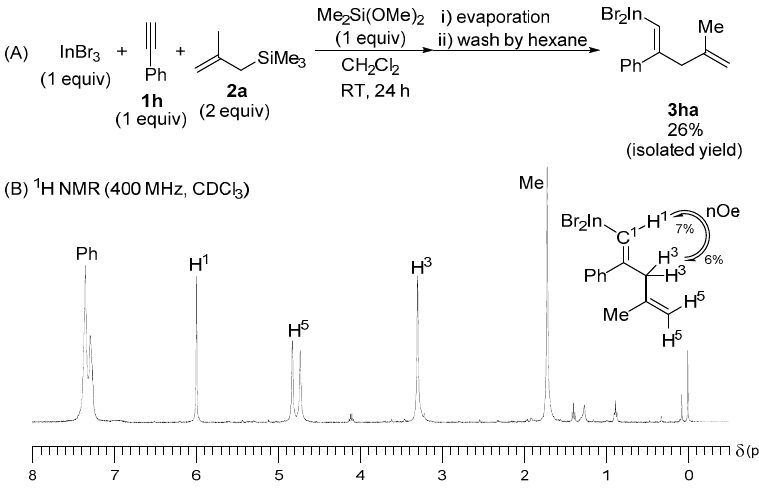
Figure 1. Isolation and characterization of 1,4-dienylindium synthesized by allylindation. ( A ) Isolation of 1,4-dienylindium 3ha . ( B ) 1H-NMR spectrum of 3ha . 1 coordinates to InBr 3 , and then the positive charge on the internal carbon atom of alkyne 1 is increased. Allylic silane 2 adds to the internal carbon atom from the opposite side of InBr 3 to give 1,4- dienylindium 3 . The iodination of 1,4-dienylindium 3 with I 2 proceeds with retention of the double bond configuration of 3 to yield alkenyl iodide 4 as a single isomer.